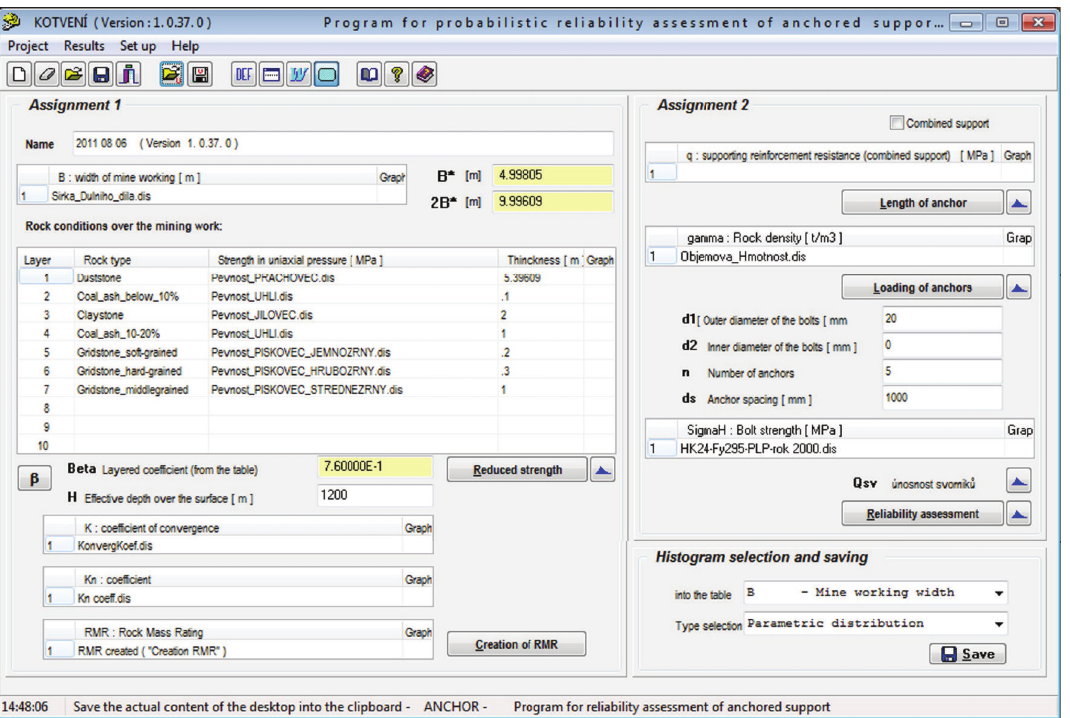
Figure 4: Desktop in the Anchor software